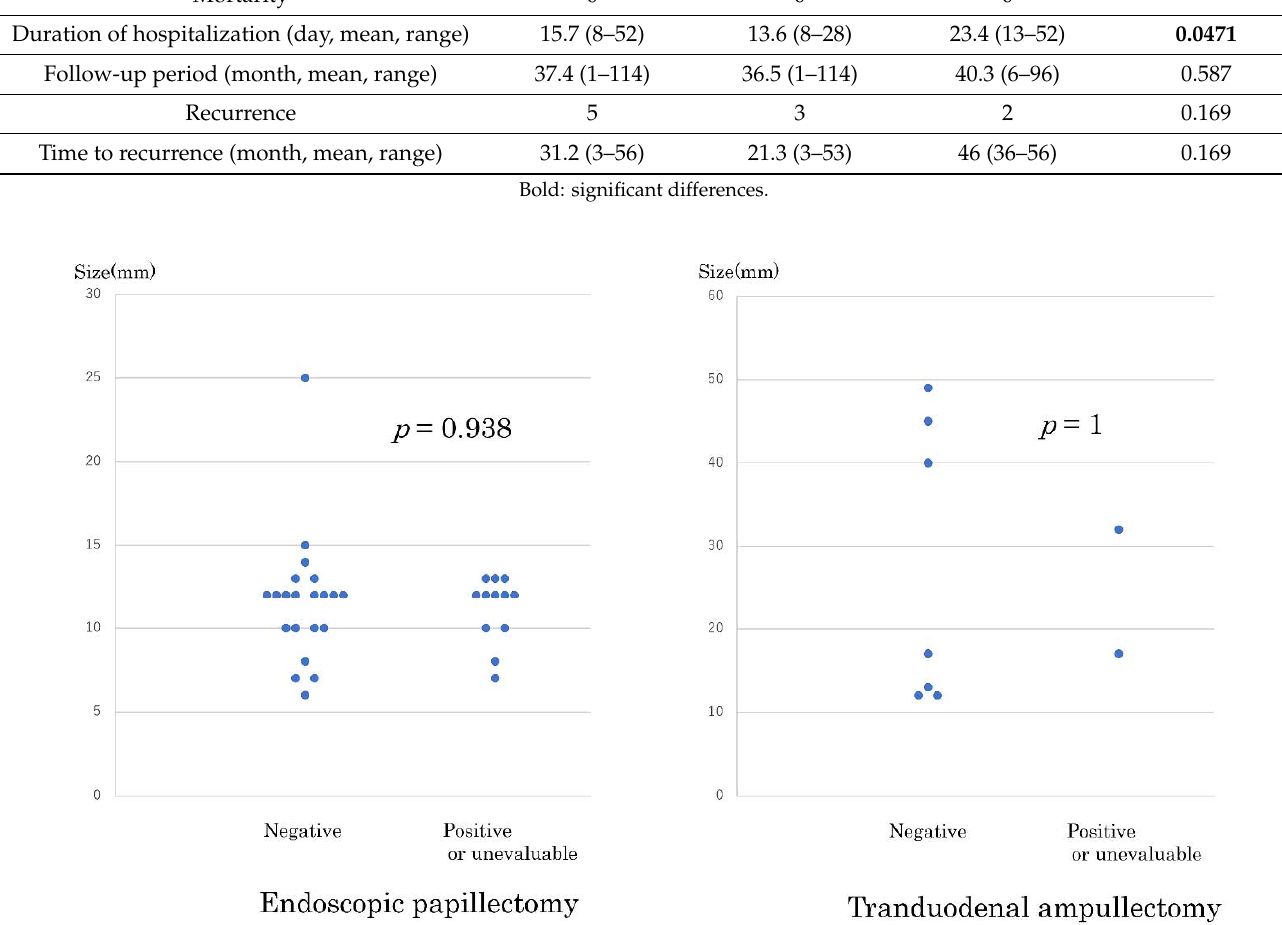
Table 3. Characteristics of patients who developed recurrence.